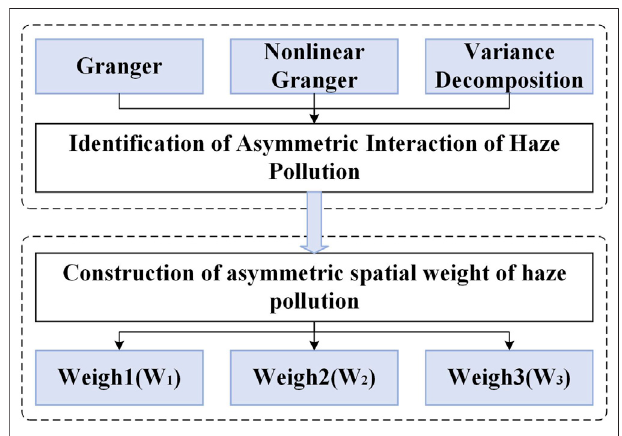
FIGURE 1 | Analytical framework for the identi fi cation of asymmetric interaction effects and weight